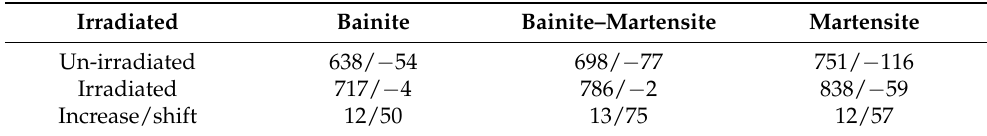
Table 8. The change of UTS and DBTT of different microstructures before and after irradiation (MPa/ ◦ C)